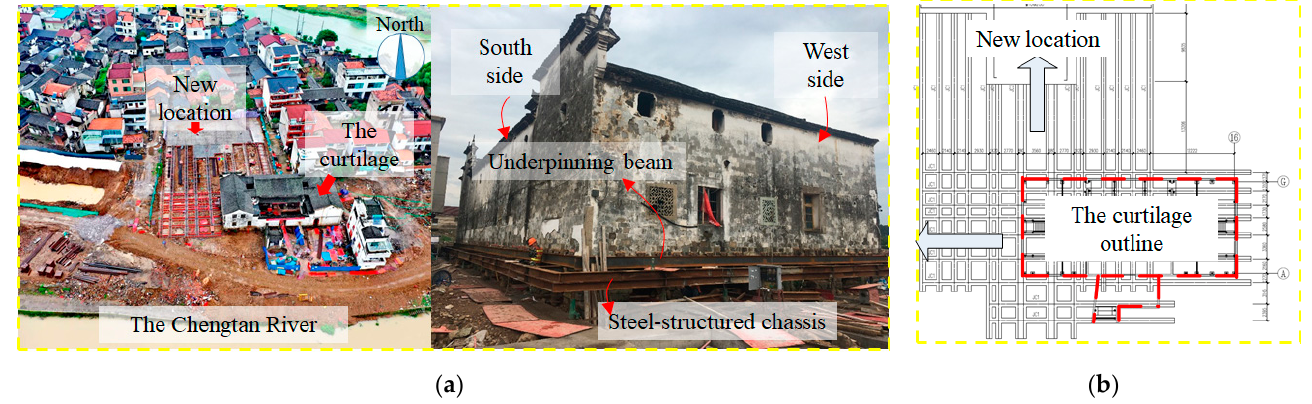
Figure 1. ( a ) The aerial view of the curtilage and its new location; ( b ) the schematic diagram of the monolithic moving procedure. monolithic moving